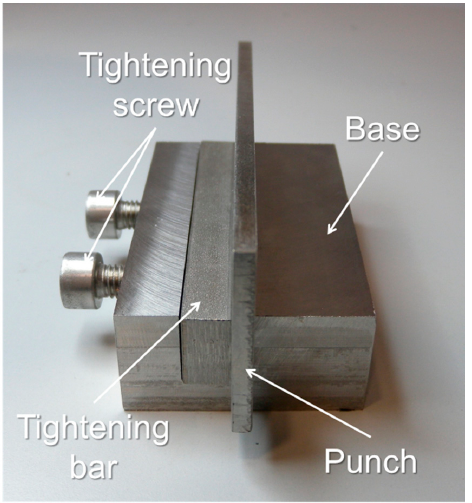
Figure 5. Assembled punch fastening tool.